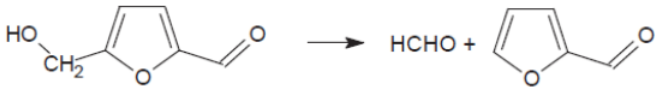
Figure 8. The formation of furfural.